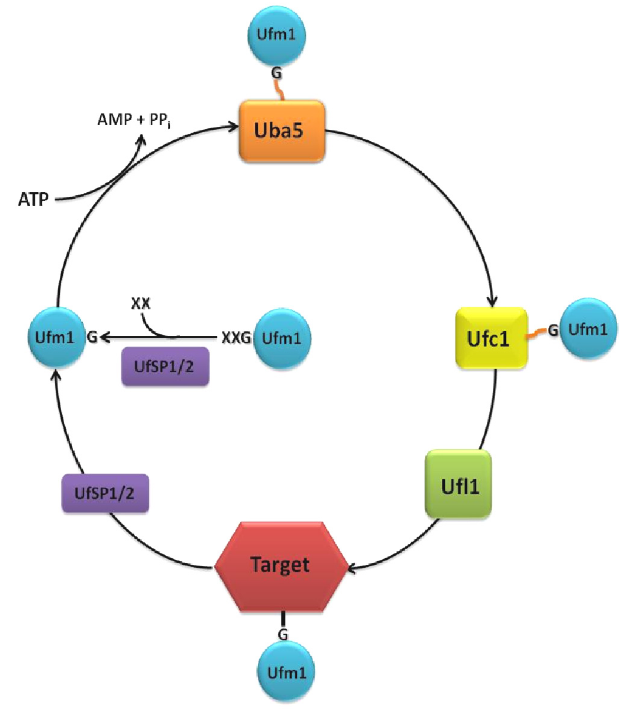
is a prerequisite for the conjugation of Ufm1 to its targets. The maturation of the pro-form of Ufm1 is processed by the proteases, UfSP1 or UfSP2, exposing a conserved glycine (G). Ufm1 is activated in an ATP-dependent reaction by the E1 activating enzyme, Uba5, creating a thioester-bond between the C-terminal glycine of Ufm1 and the active cysteine residue of Uba5. Ufm1 is then transferred to the active cysteine of the E2 conjugating enzyme, Ufc1. With the aid of the E3 ligase, Ufl1, an isopeptide bond between Ufm1 and the target protein is established. Deconjugation is also catalyzed by UfSP1 or